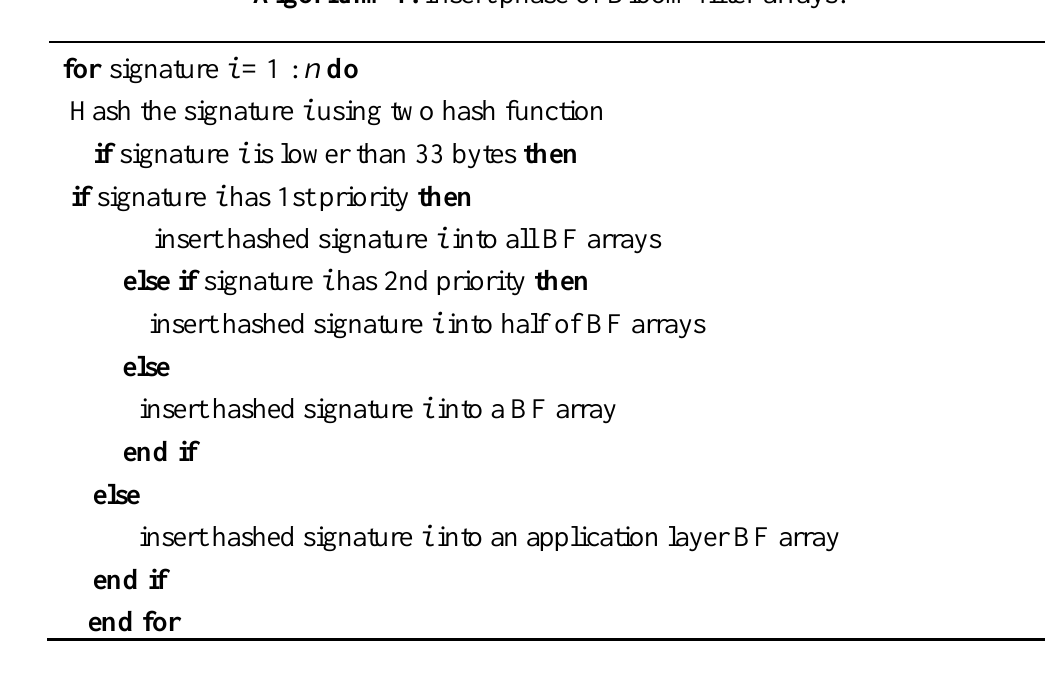
Algorithm 1. Insert phase of Bloom filter arrays.